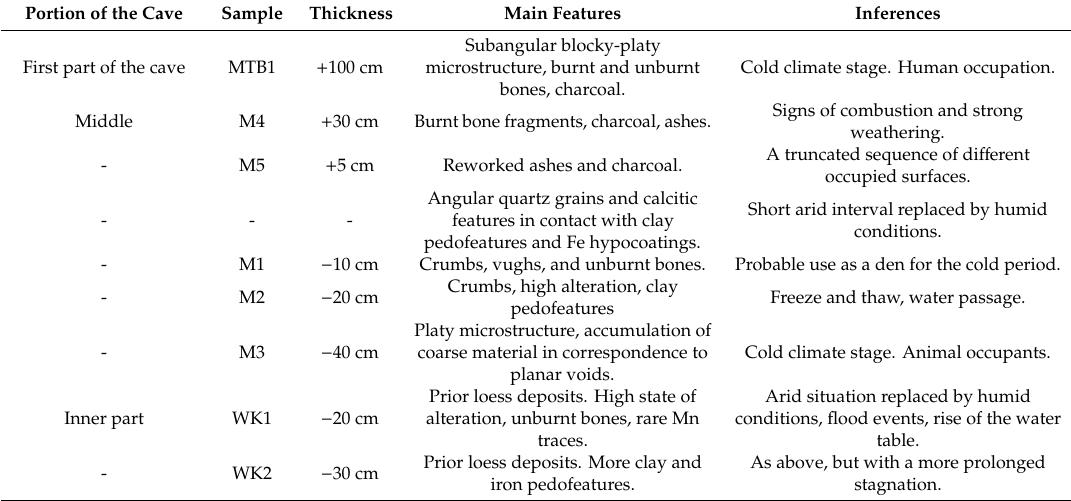
Table 1. Summary of micromorphological observations and